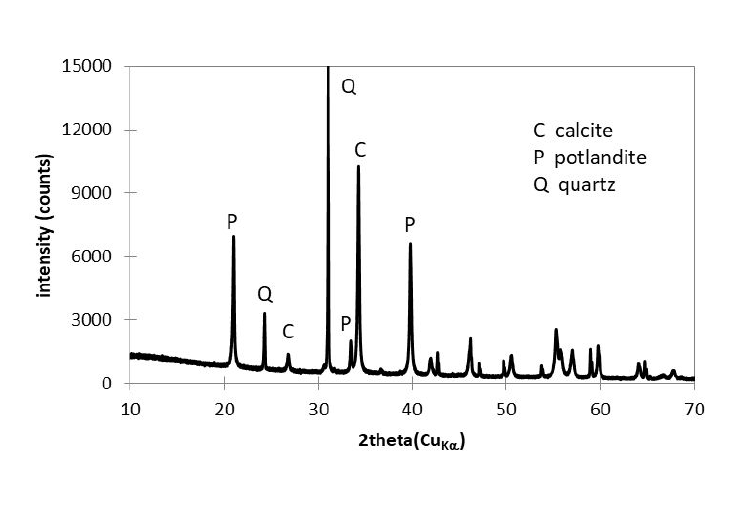
Figure 1. Phase composition of lime mortar under study.